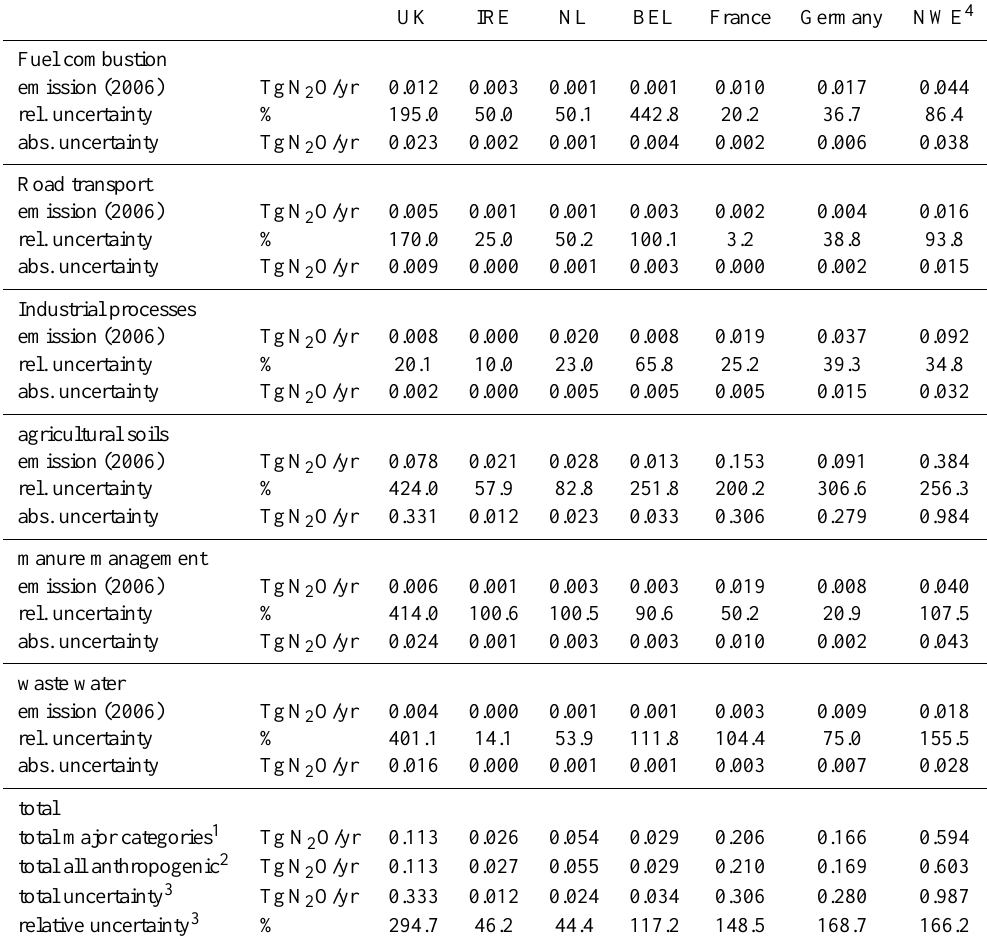
Table 6. Uncertainty estimates (2 σ ) for emissions reported to UNFCCC for the north-western Europe countries (NWE: Germany, France, Benelux, UK and